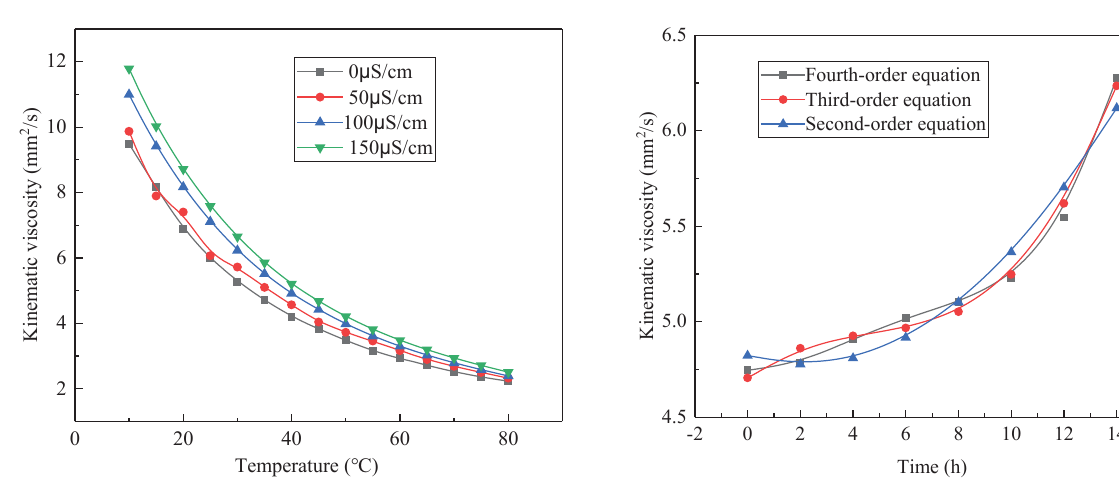
Figure 3: The curve fitting of kinematic viscosity and temperature of biodiesel with different conductivity.